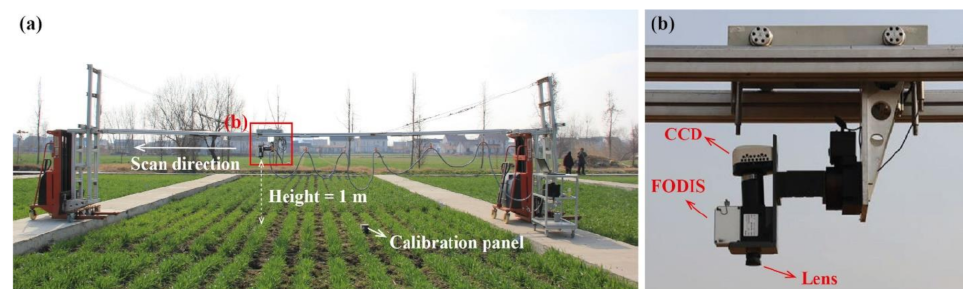
Figure 1. Near-ground hyperspectral imaging system. ( a ) Setup of the system in the experimental wheat field, and ( b ) the onset of the hyperspectral imaging spectrometer (V10E-PS) in the system. FODIS is a fiber optic downwelling irradiance